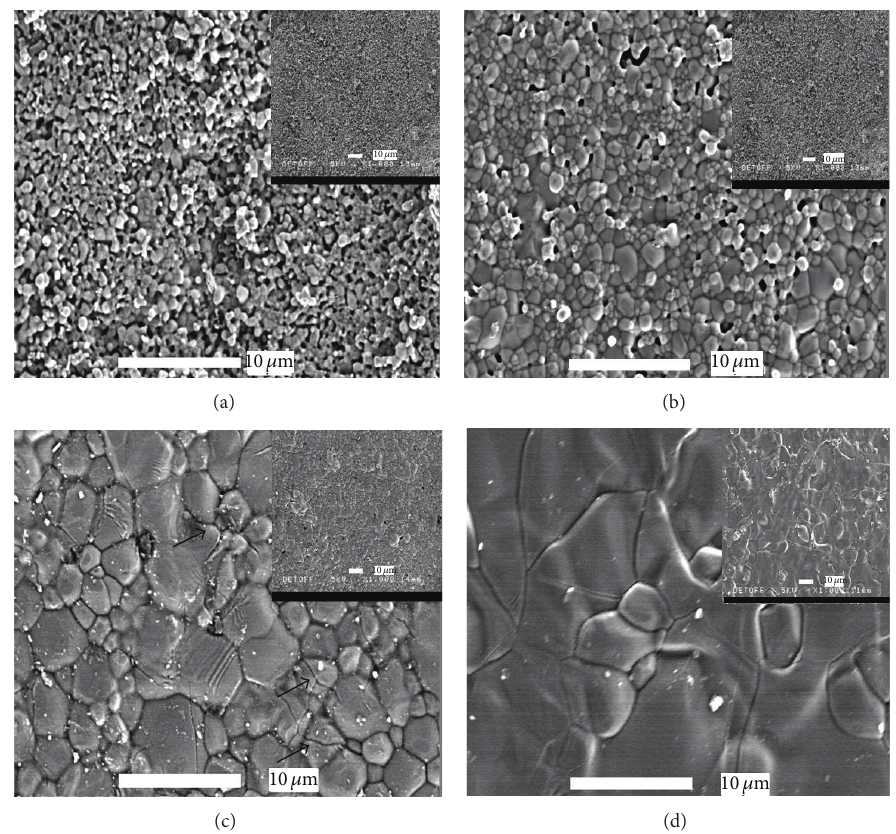
Figure 2: Microstructure of the BCP samples sintered at (a) 1000 ∘ C, (b) 1100 ∘ C, (c) 1200 ∘ C, and (d) 1300 ∘ C, observed at low ( × 1000; insets) and high ( × 3500; main images) magnifications.